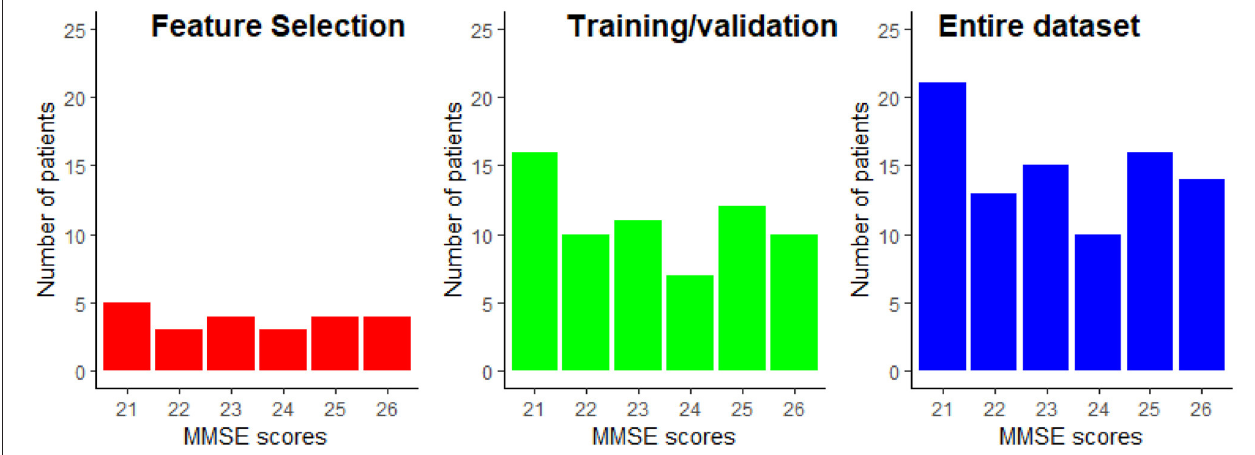
FIGURE 5 | Example of the MMSE distributions for the feature selection and the train/validation datasets. The MMSE distribution of the entire dataset is provided as